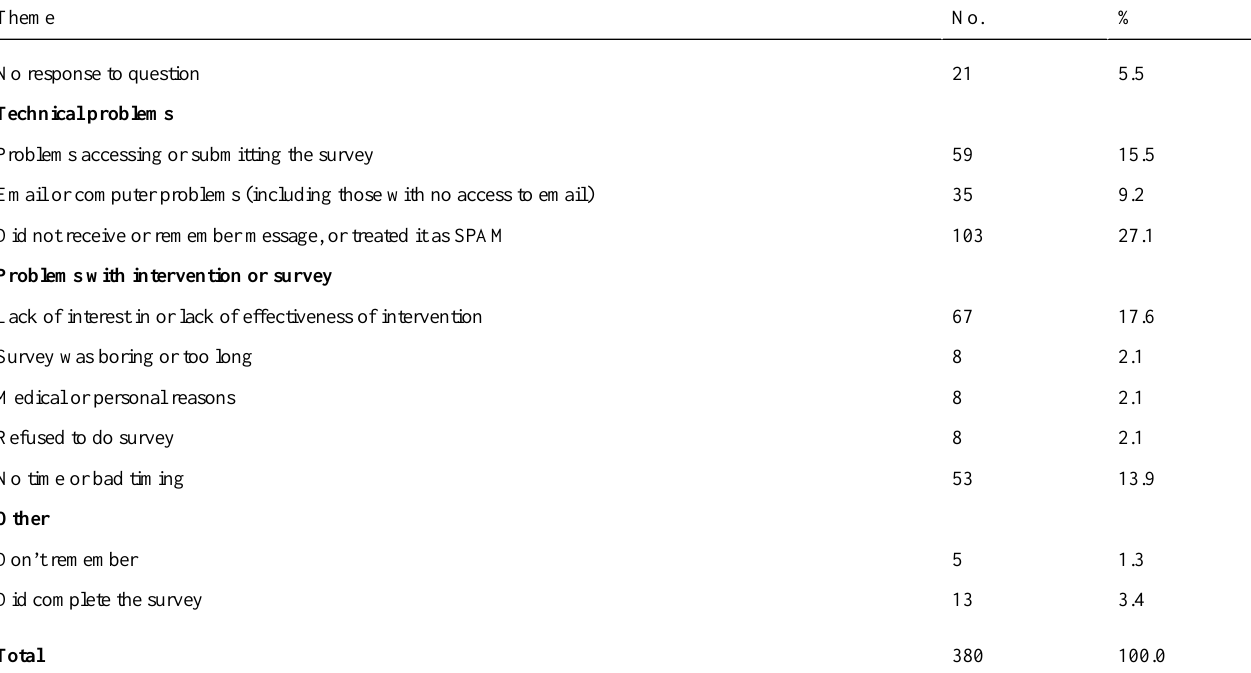
Table 3. Classification of reasons for noncompletion of the online survey into major themes